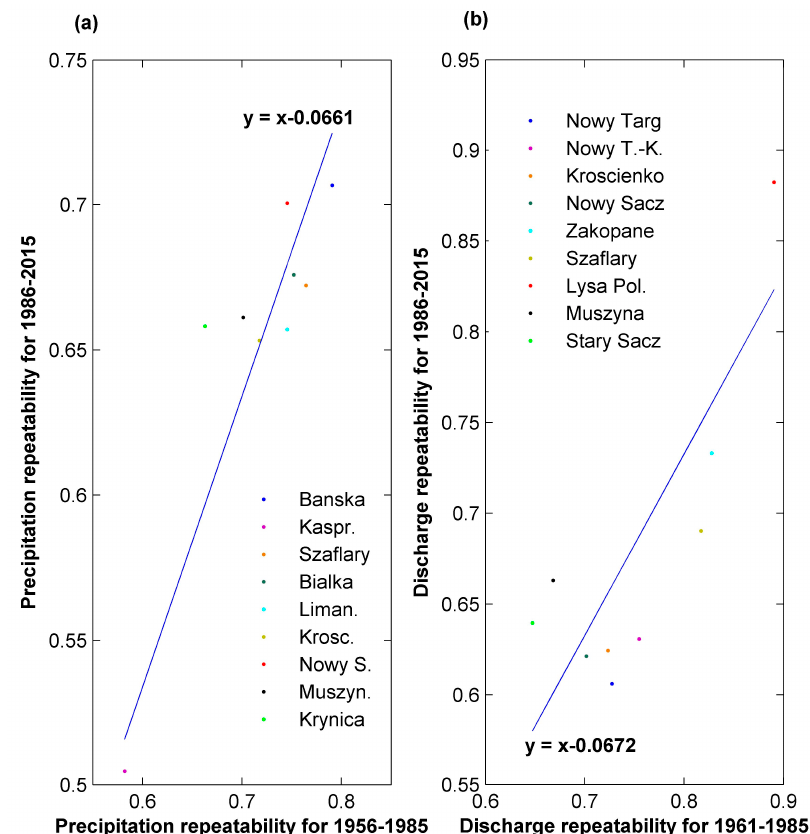
Figure 6. Repeatability of the studied process of ( a ) precipitation and ( b ) river flow for two